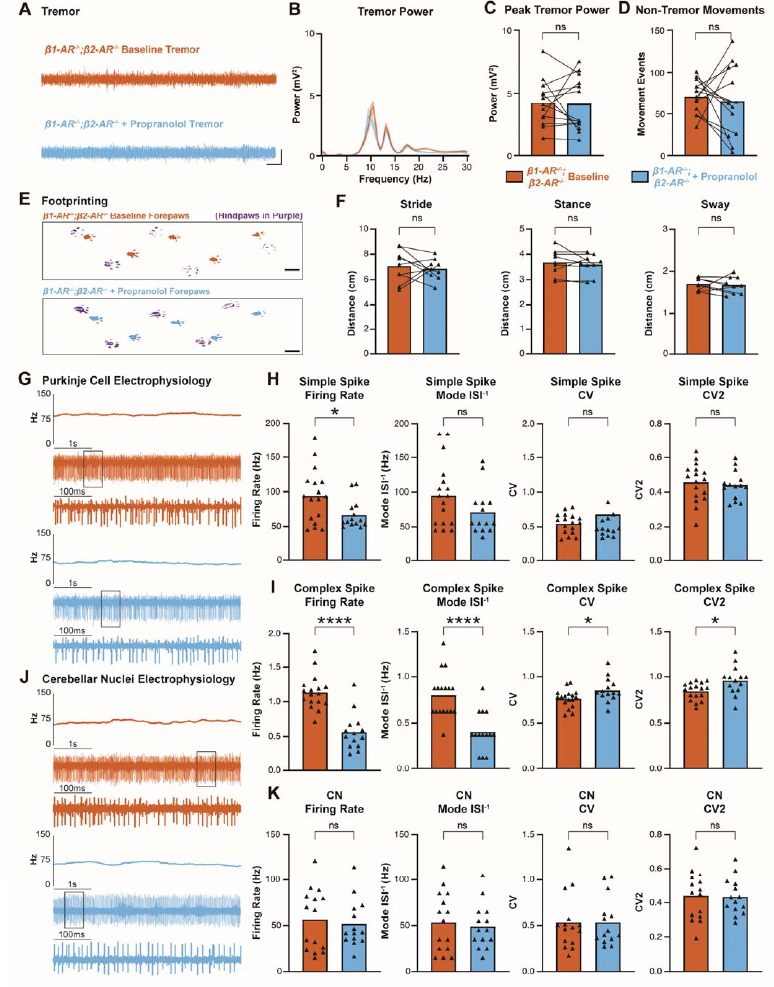
Figure 6. Propranolol does not modulate tremor, gait, or cerebellar nuclei neuron activity in mice lacking β 1 and β 2 adrenergic receptors. ( A ) Representative raw traces of tremor readings recorded from the tremor monitor for β 1-AR − / − ; β 2-AR − / − mice at baseline (vermillion, N = 11), and after propranolol treatment (sky blue, N = 13). The same color assignment for each group is maintained throughout the remaining figure panels (legend below panels ( C , D )). Scale bar is 50 mV vertical and 500 ms horizontal. ( B ) Line graph depicting tremor power versus frequency. Color representation for groups is maintained from panel A . ( C ) Bar graph showing quantifications of peak tremor power at baseline and after propranolol treatment in β 1-AR − / − ; β 2-AR − / − mice with lines connecting each animal’s data before and after treatment. There is no significant difference in peak tremor power after β 1-AR − / − ; β 2-AR − / − mice receive propranolol. * = p < 0.05; **** = p < 0.0001; ns = not significant, p > 0.05. ( D ) Quantifications of non-tremor movements show no significant difference between β 1- AR − / − ; β 2-AR − / − mice at baseline or after being treated with propranolol. ( E ) Representative traces of forepaw footprinting assays recorded from β 1-AR − / − ; β 2-AR − / − mice before and after propranolol (N = 9). Hindpaw prints are in shown in purple for context. Scale bar is 1 cm. ( F ) Quantifications of footprinting assays. Lines connect before and after treatment data for each animal. There is no significant difference before and after propranolol for stride, stance, or sway in β 1-AR − / − ; β 2-AR − / − mice. ( G ) Representative raw electrophysiological traces of Purkinje cell activity in β 1-AR − / − ; β 2-AR − / − mice before (N = 5, n = 17) and after propranolol treatment (N = 4, n = 14). The line graph at the top for each condition represents the mean firing rate in Hz at each point in time for the 5 s spike traces shown below each line graph. Below the 5 s spike traces are magnified views of the spikes within the